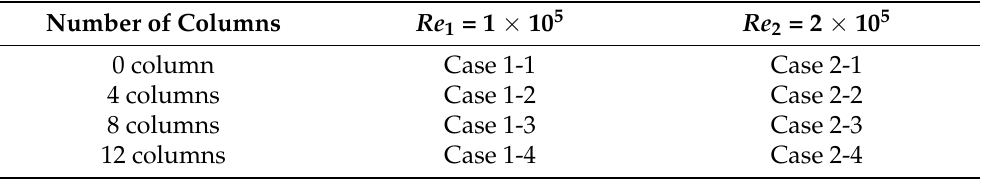
Table 1. Included cases of the numerical